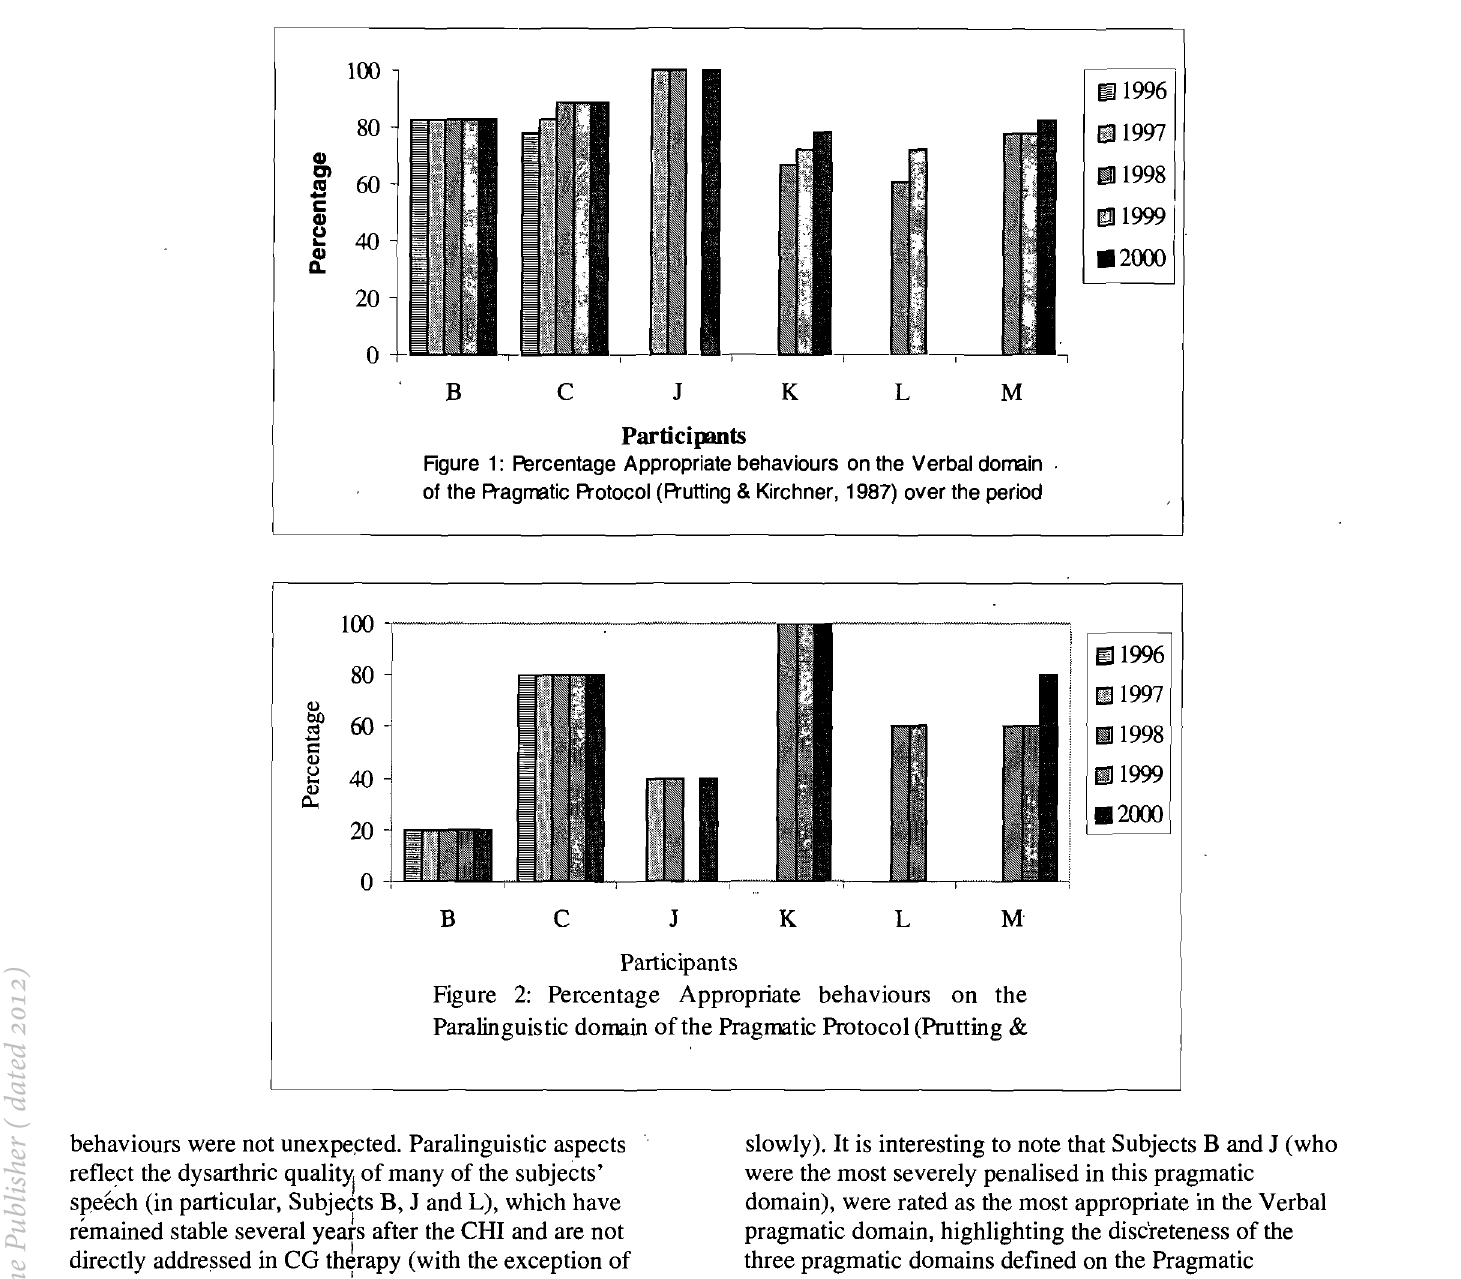
Figure 2: Percentage Appropriate behaviours on the Paralinguistic domain of the Pragmatic Protocol (Prutting &